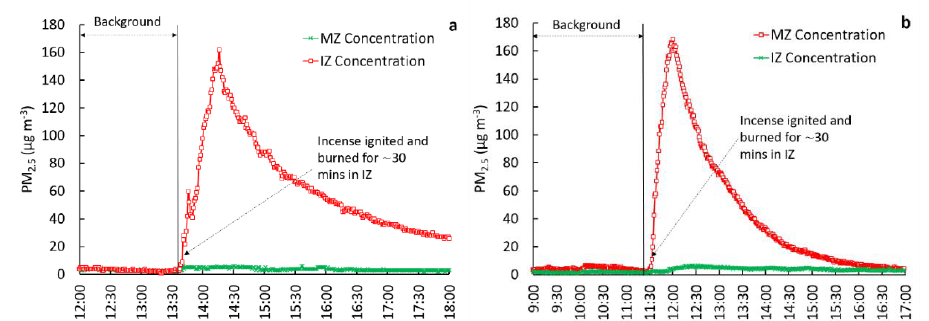
Figure 1. Comparison of PM 2.5 concentrations in the IZ and MZ under the IZ windows closed, bath exhaust ventilation off (Test 1) scenario with trial 1 on the left ( a ) and trial 2 on the right ( b ). a : explanation; b : explanation.